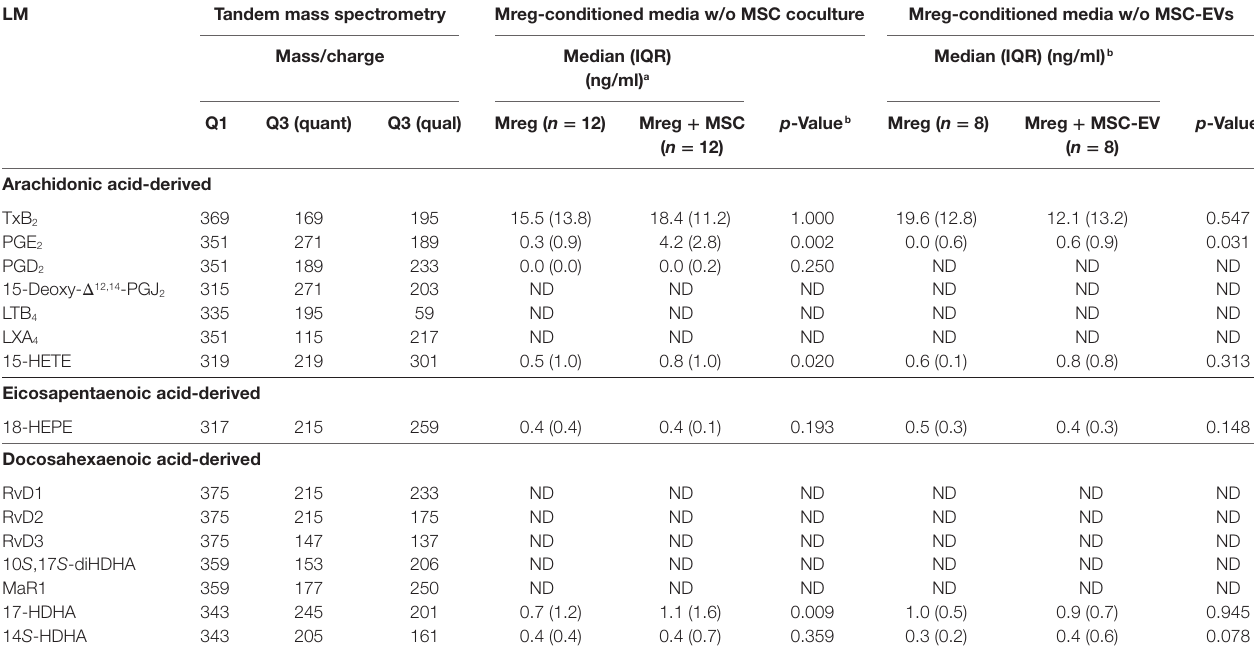
Table 3 | Levels of lipid mediators